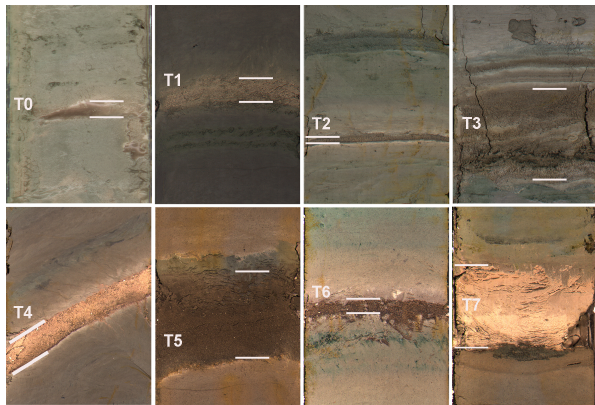
Figure 2. Photos of core sections with detected tephra layers from Lake El’gygtgyn: T0 (core Lz1024-5 I), T1 (core 5011-1B-1H2), T2 (core 5011-1B-7H2), T3 (core 5011-1B-10H2), T4 (core 5011- 1A-19H1), T5 (core 5011-1A-19H2), T6 (core 5011-1A-25H1), T7 (core 5011-1A-35E1). Length of each segment is